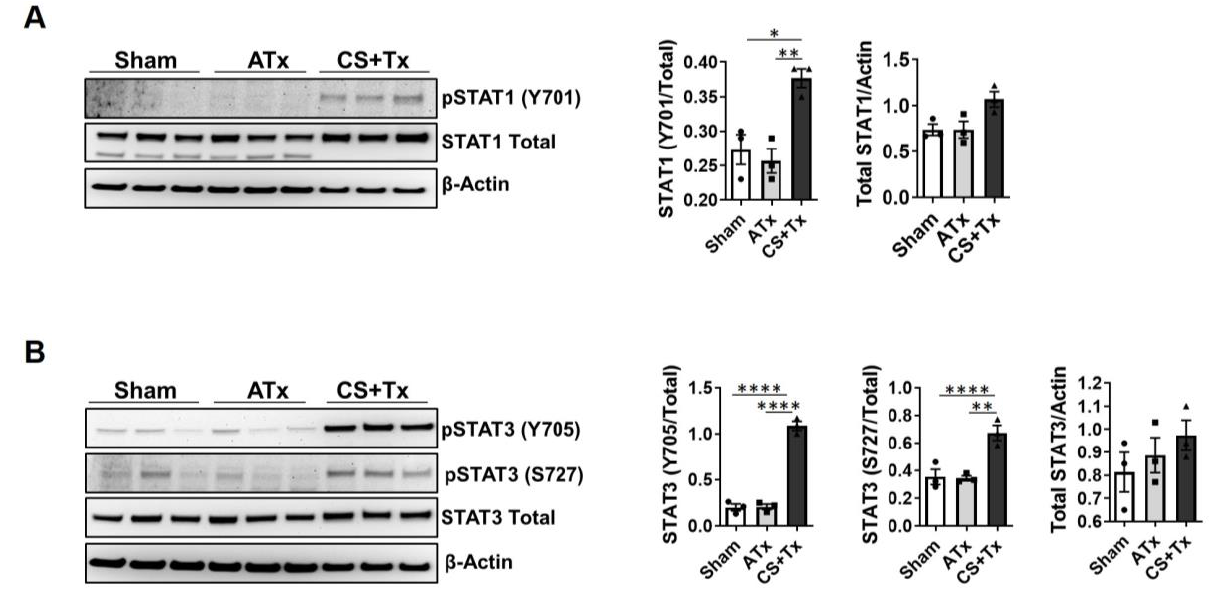
Figure 1. Activation/induction of STAT after cold storage and transplantation. Experimental groups post-1 day of reperfusion; healthy Sham, auto-transplant (ATx) without CS, and transplant after 18 h CS exposure (CS + Tx) shown. ( A , B ) Homogenized kidneys lysed with RIPA (30 µ g) were loaded for SDS-PAGE Western assays and figures depict densitometric analysis of ( A ) Y701-phosphorylated/total STAT1, as well as ( B ) Y705- and S727-phosphorylated/total STAT3. Representative blots from 3 independent experiments show mean ± SEM (bars, n = 3). Data were computed using 1-way ANOVA followed by Brown–Forsythe and Welch’s corrections for multiple group comparisons; p < 0.05 is considered significant. *, p < 0.05; **, p < 0.01, ****, p < 0.001. Each solid circle, square, or triangle represent individual animals within the group.